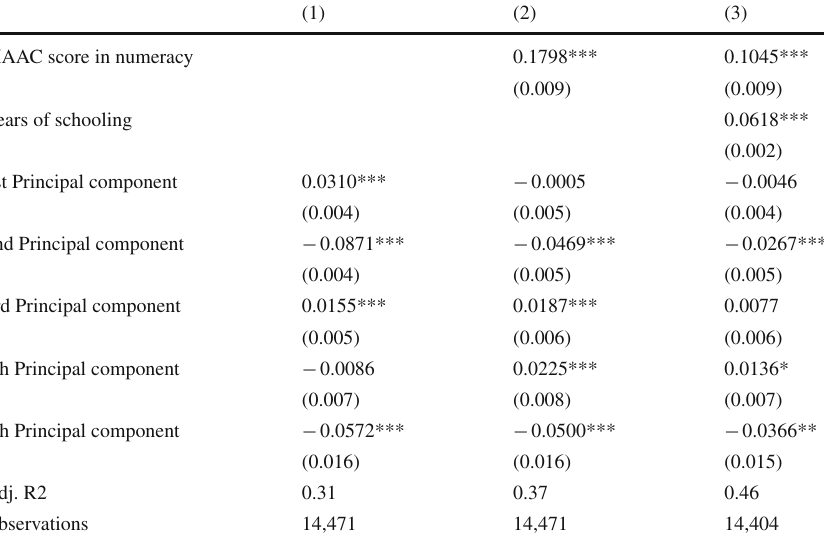
Table 12 Non-cognitive skills in the Mincerian equation by level of education using principal